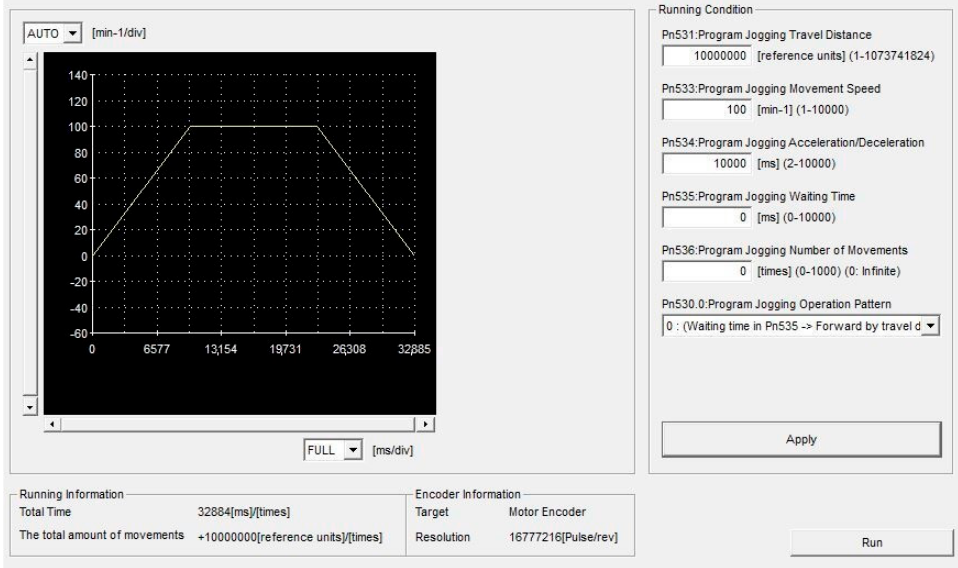
Figure 13. Speed curve of the servo motor SGM7J-02AFC65.